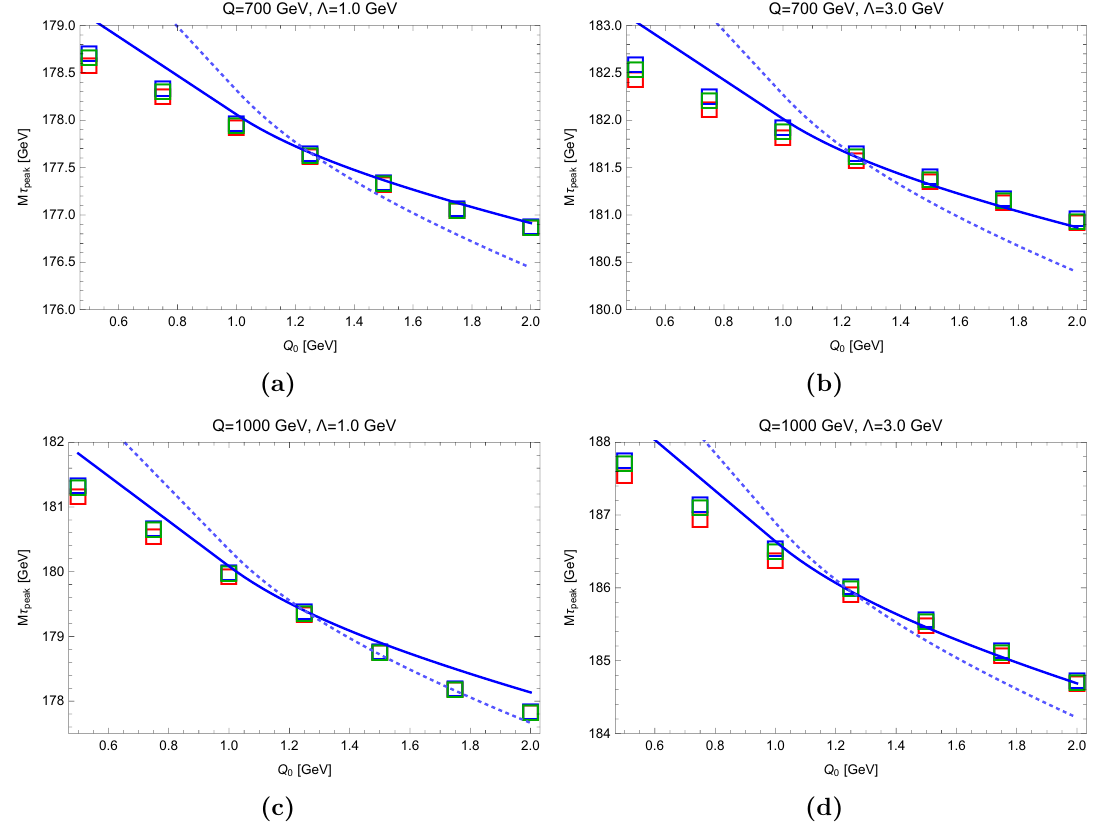
Figure 12. Peak position M (cid:28); peak at the parton level obtained from Herwig 7 for the top quark generator mass m t = 173 GeV as a function of the shower cut Q 0 for Q = 700 GeV (upper panels) and Q = 1 TeV (lower panels) for smearing (cid:3) = 1 GeV (left panels) and (cid:3) = 3 GeV (right panels). Displayed are the results from the full simulation (red squares), with gluon splitting turned o(cid:11), but angular ordering turned on (blue squares) and with gluon splitting and angular ordering both turned o(cid:11) (green squares). The blue solid line is the analytic prediction of eq. (7.2) taking the Herwig 7 result for Q 0 = 1 : 25 GeV as the reference. The dashed blue line is the analytic prediction of 0 eq. (7.2), but only accounting for the large angle soft radiation contributions which are multiplied with the Q=m t factor.